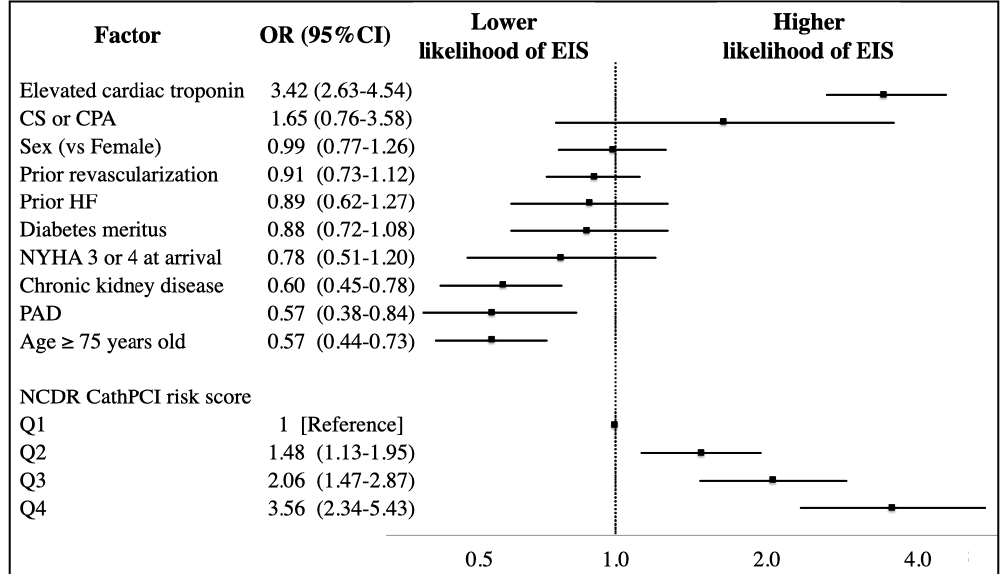
Figure 3. Important independent predictors of early invasive strategy utilization. Adjusted ORs (point estimate) and 95% CIs (error bars) indicate the likelihood of early invasive strategy utilization. ORs < 1 indicate decreased odds of early invasive strategy utilization. Covariates: sex, age ( ≥ 75 years), prior heart failure, diabetes mellitus, PAD, chronic kidney disease (eGFR < 60 ml/min/1.73 m 2 ),